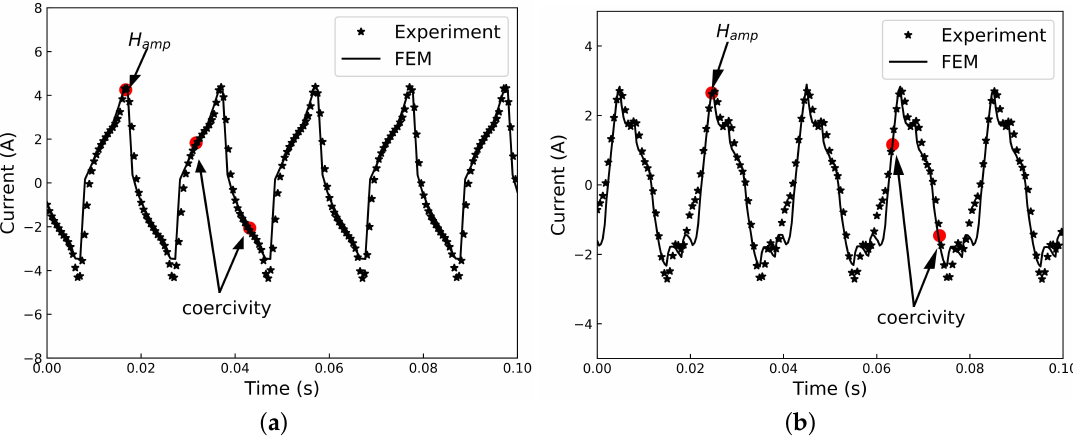
Figure 9. The comparison between the FEM and experiment results of 270 V excitation under ( a ) B-phase and ( b ) three-phase